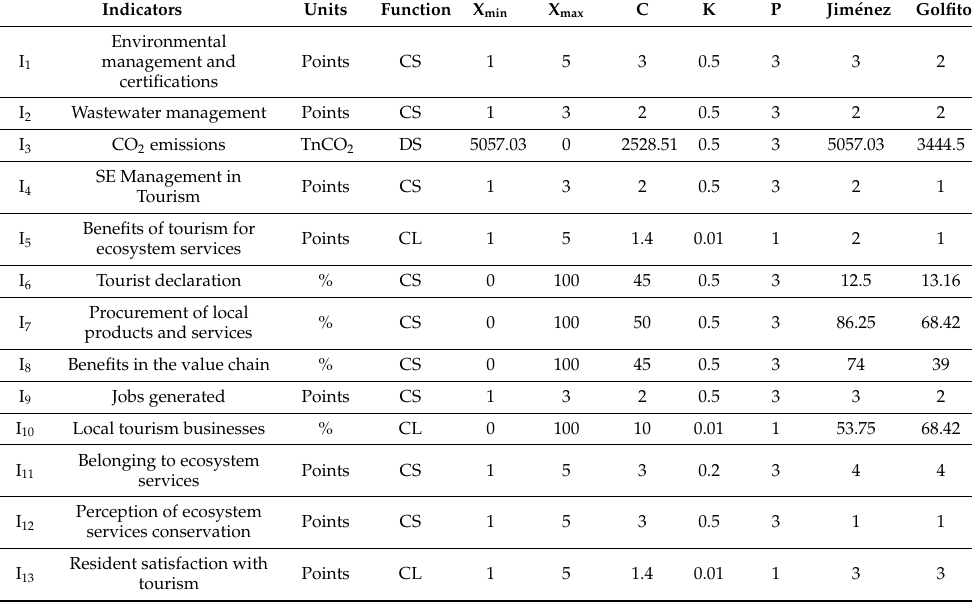
Table 4. Evaluation parameters and value functions assigned for the evaluation model. To interpret the table, C: approximates the abscissa of the inflection point, K: approximates the ordinate of the inflection point, P: is a shape factor that defines whether the curve is concave, convex, linear, or S-shaped, CS: S-shaped increasing function, DS: S-shaped decreasing function, CL: Linear increasing function, X min minimum satisfaction, X max maximum